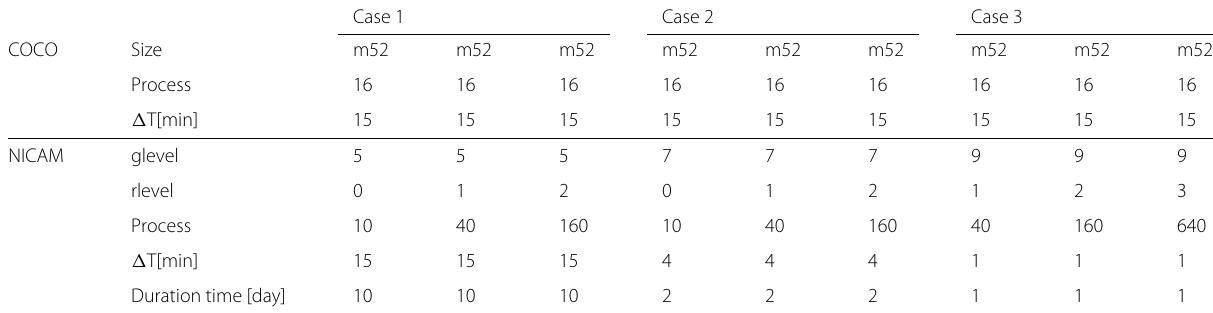
Table 6 Experimental conditions of NICAM–COCO coupling